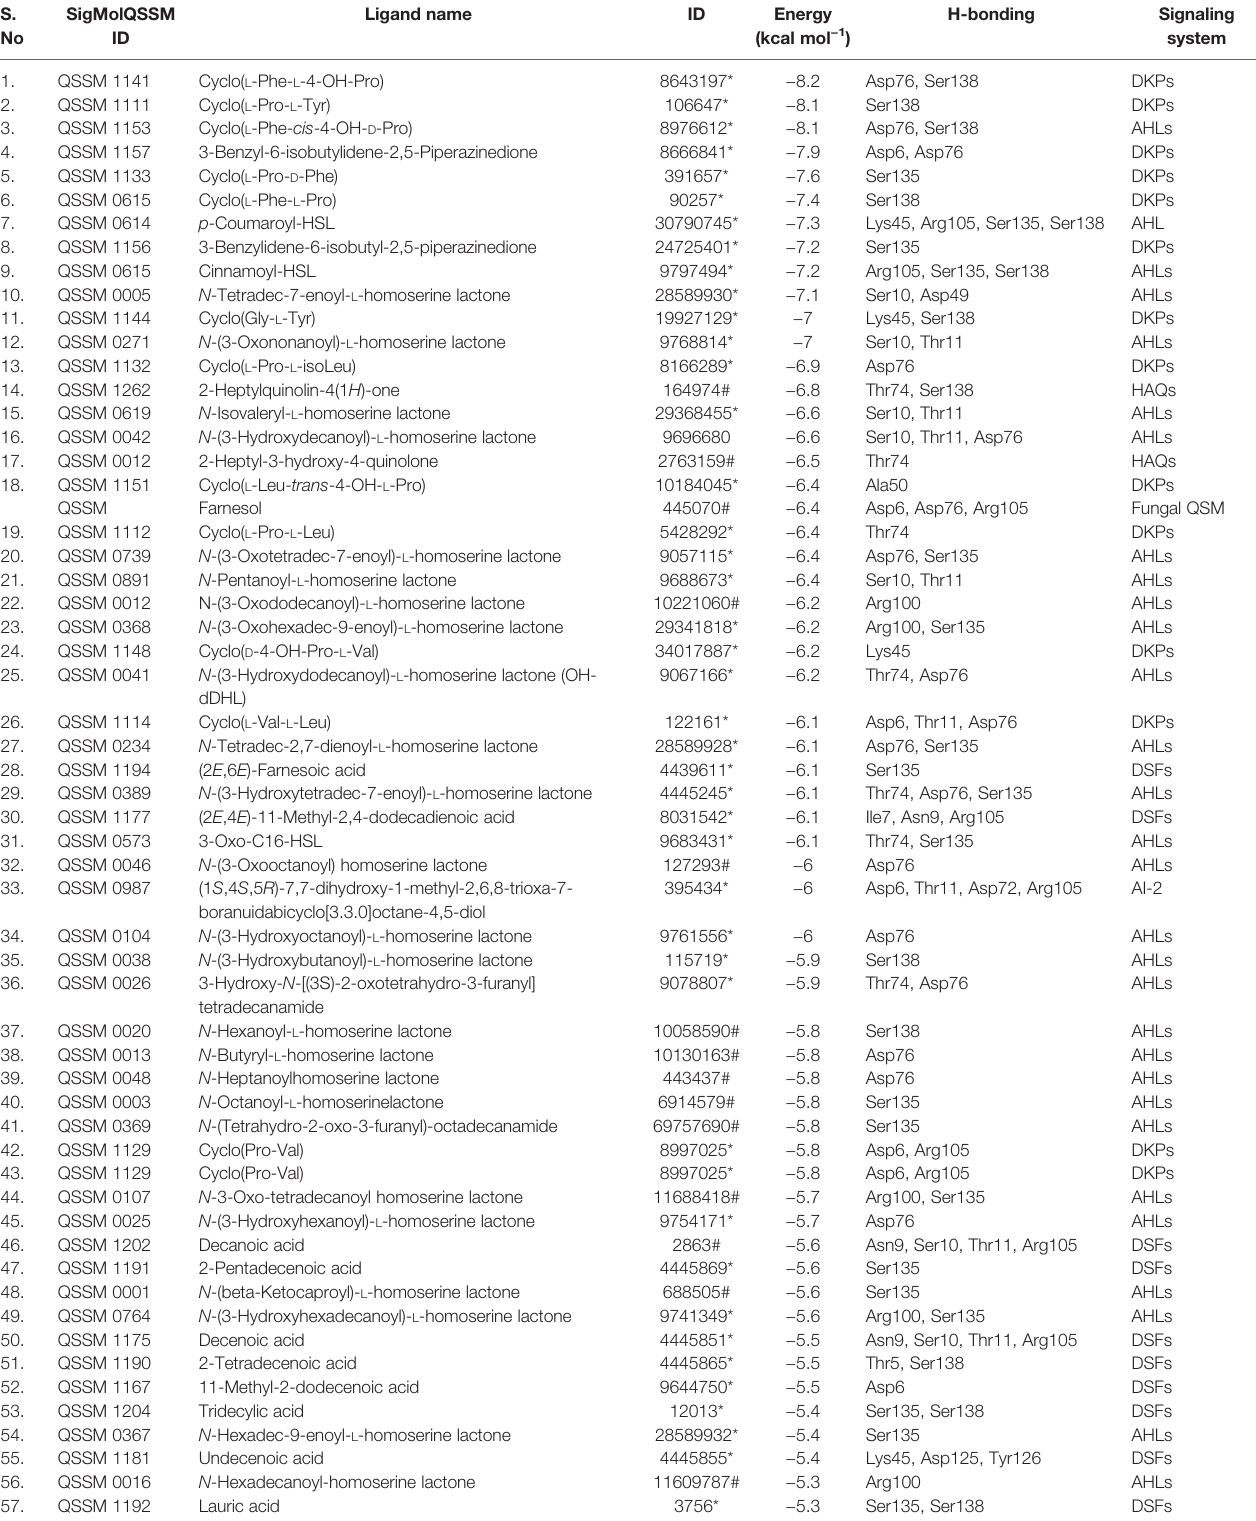
TABLE 1 | List of the 64 screened QSMs with their binding energy and interaction residues against CYCc as predicted through virtual docking. S.